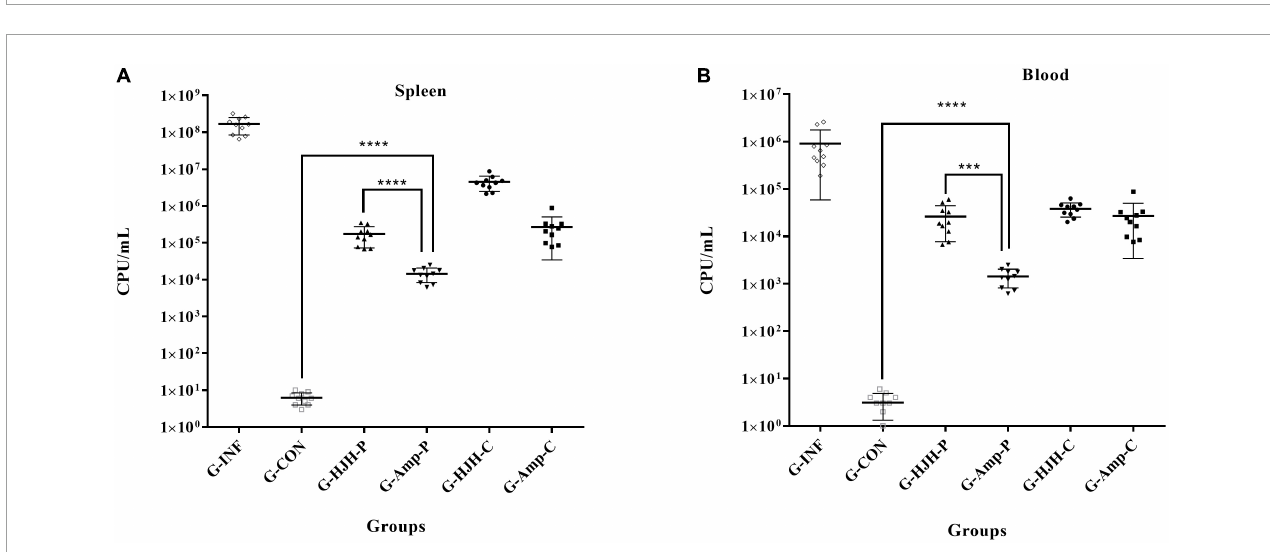
FIGURE6 Bacterial load in spleen and blood of different treatment groups. For the prophylaxis group, HJH-3 or Ampicillin was used by injected intraperitoneally (IP) (200 µ g/mL, 0.5 mL), and then the chickens were infected with S. Pullorum. For the treatment group, the chickens were infected with S. Pullorum, and then HJH-3 or Amp was used by IP (200 µ g/mL, 0.5 mL). Each point represents data from a single animal, and the line shows the mean value. Results are expressed mean ± SEM and the statistical analysis was performed using the unpaired Student’s t -test. *** P < 0.001, **** P < 0.0001. (A) Bacterial load in spleen; (B) bacterial load in